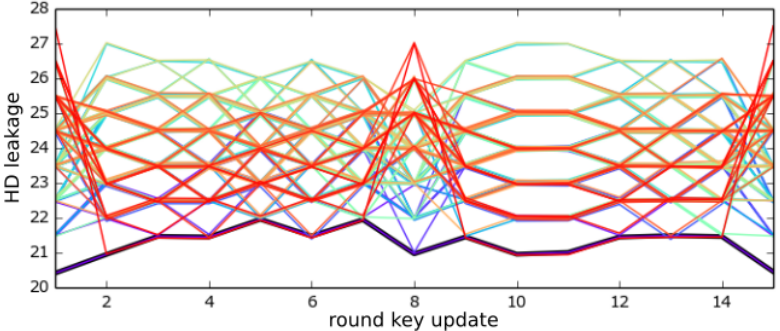
Figure 19: Simulated trace means for all 128 classes of one subkey using 1 million traces. The mean trace of the class with index 0 is highlighted in